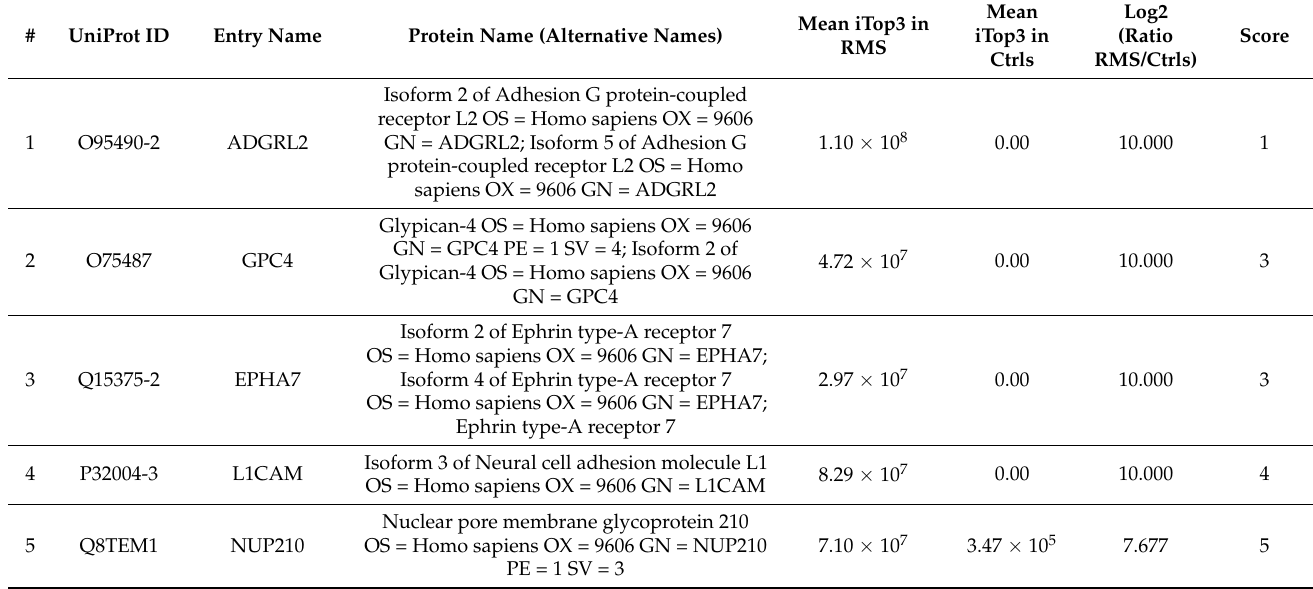
Table A1. List C: “Top100” list of surface proteins ranked by the criteria of the MS scoring